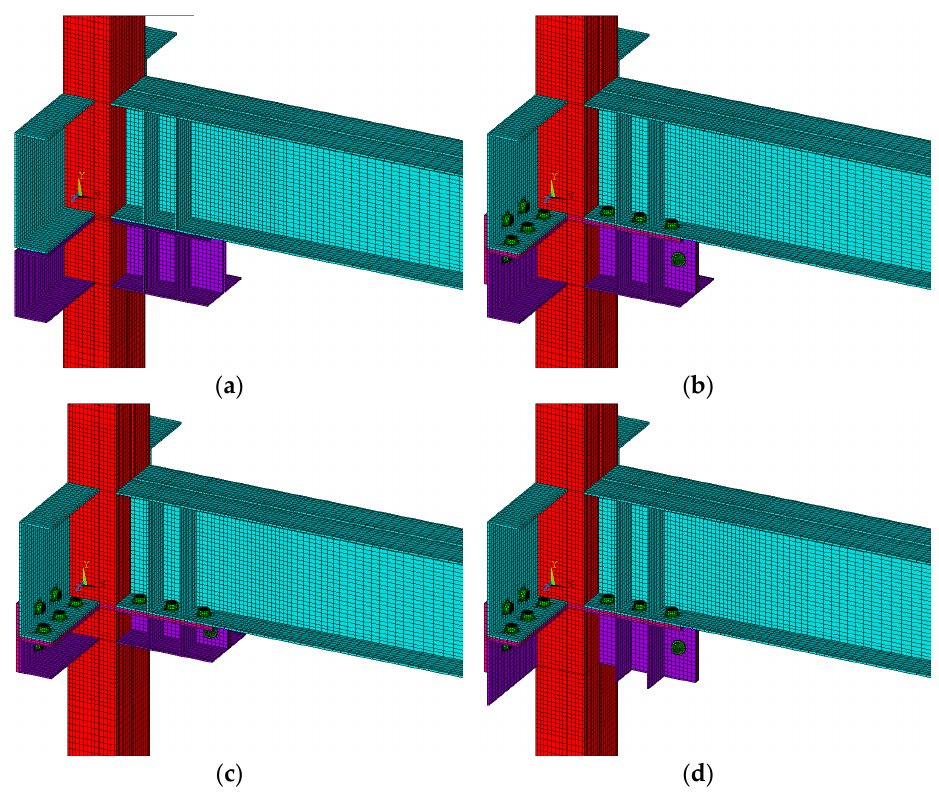
Figure 9. Finite element modeling of the specimens. ( a ) C200-W; ( b ) C200-B; ( c ) C100-B; ( d ) L200-B.